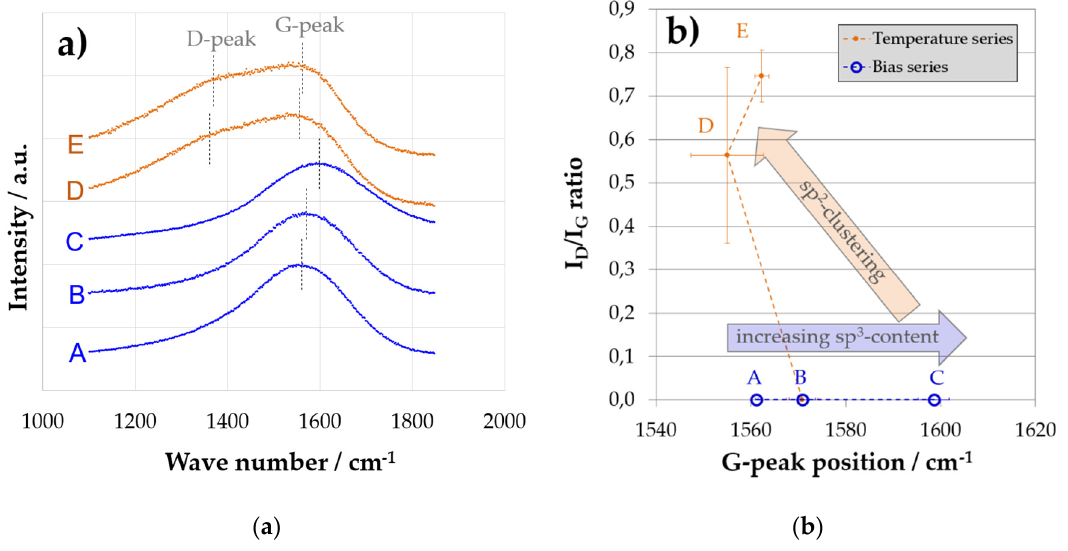
Figure 6. Raman plots ( a ) and results of the fitted Raman spectra are shown as I D /I G peak height ratio over G peak position ( b ), visualizing independent influence of temperature and bias voltage on structural parameters. The blue arrow indicates direct correlation with an increased sp 3 ratio, hardness, and Young’s modulus, where I D /I G ≈ 0. The red arrow indicates an increase in graphitic nanoclusters with an emerging D peak.